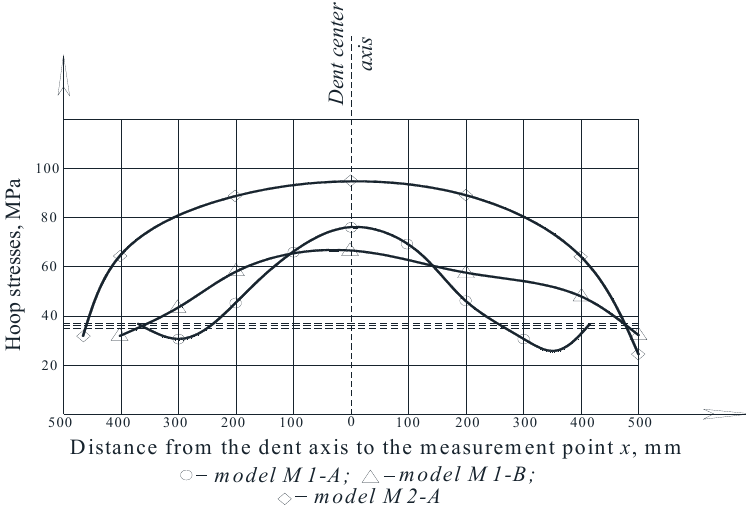
Figure 9. Diagrams of the hoop stresses in the dent zone [33].